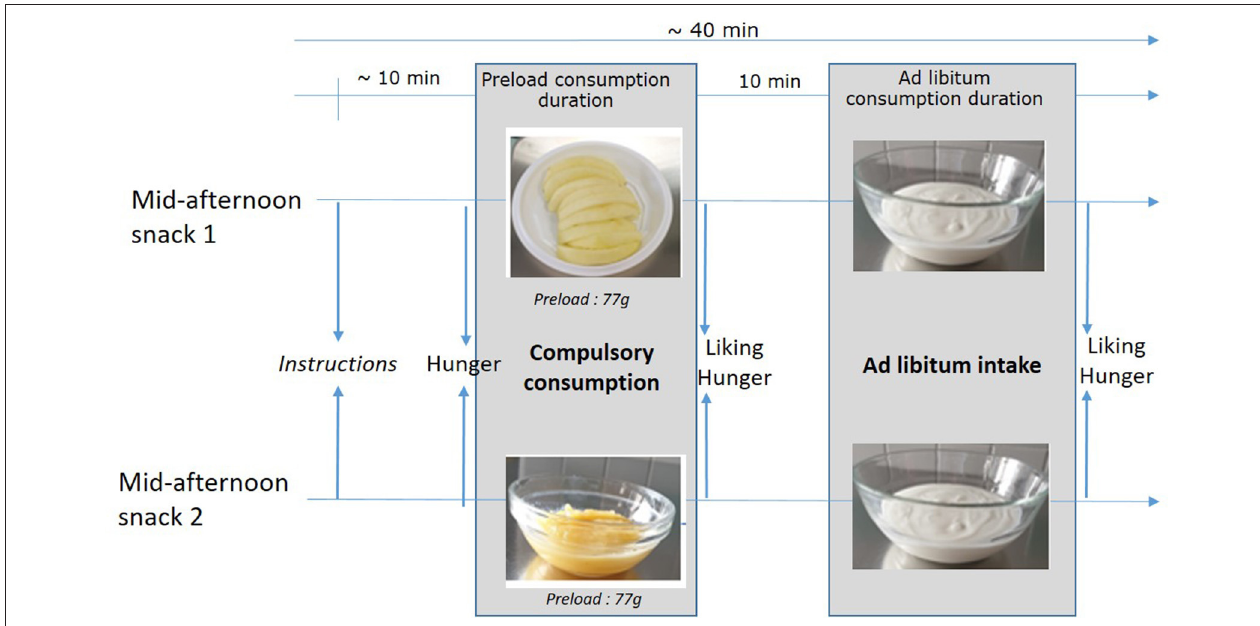
FIGURE 1 | Mid-afternoon snack design (preload and ad libitum consumption durations were left to the discretion of the child and are presented in Table 4 ; mid-afternoon snacks starting with apple segments or applesauce were balanced between children).